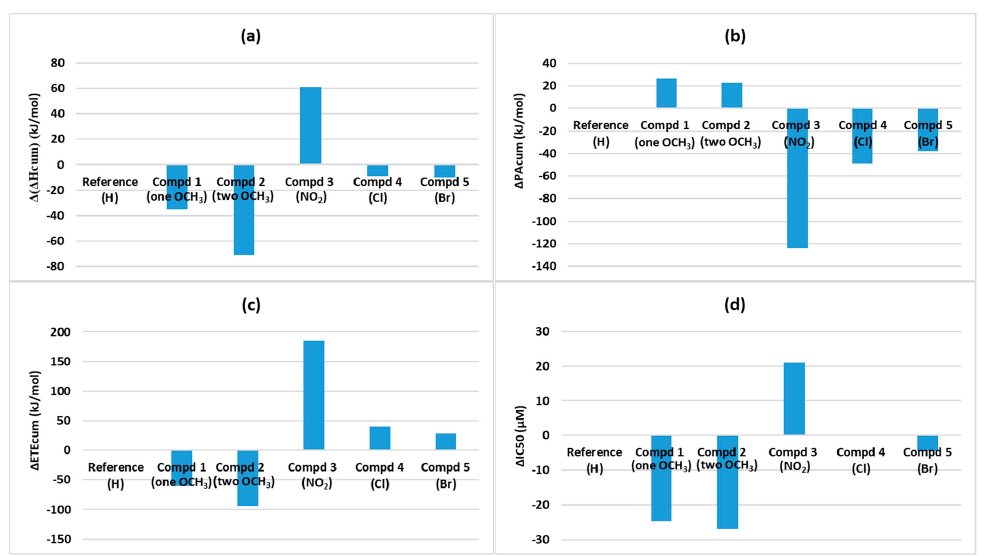
Figure 6. Graphical representation of the enthalpy deviation of each compound from the value of the reference compound: ( a ) ∆ ( ∆ H cum ), ( b ) ∆ PA cum , ( c ) ∆ ETE cum and ( d ) ∆ IC50.